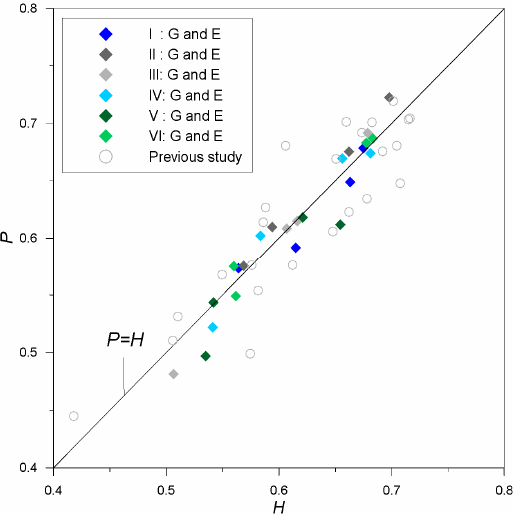
Figure 4. Fitted line between preference P and harmony H for all images in this study and compared with previous study [29] Note that we do not distinguish P and H values between different survey respondent groups (expert, E, and general public, G) but we instead average all survey data for each image.